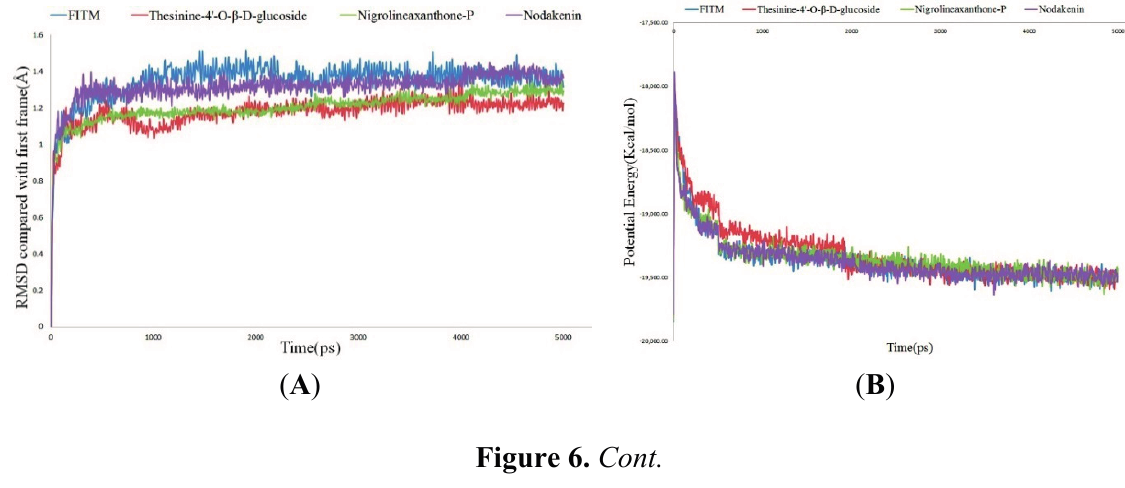
Figure 5. Pharmacophore mapping results and molecular docking results of thesinine-4 ʹ - O - β - D -glucoside, nigrolineaxanthone-P and nodakenin.